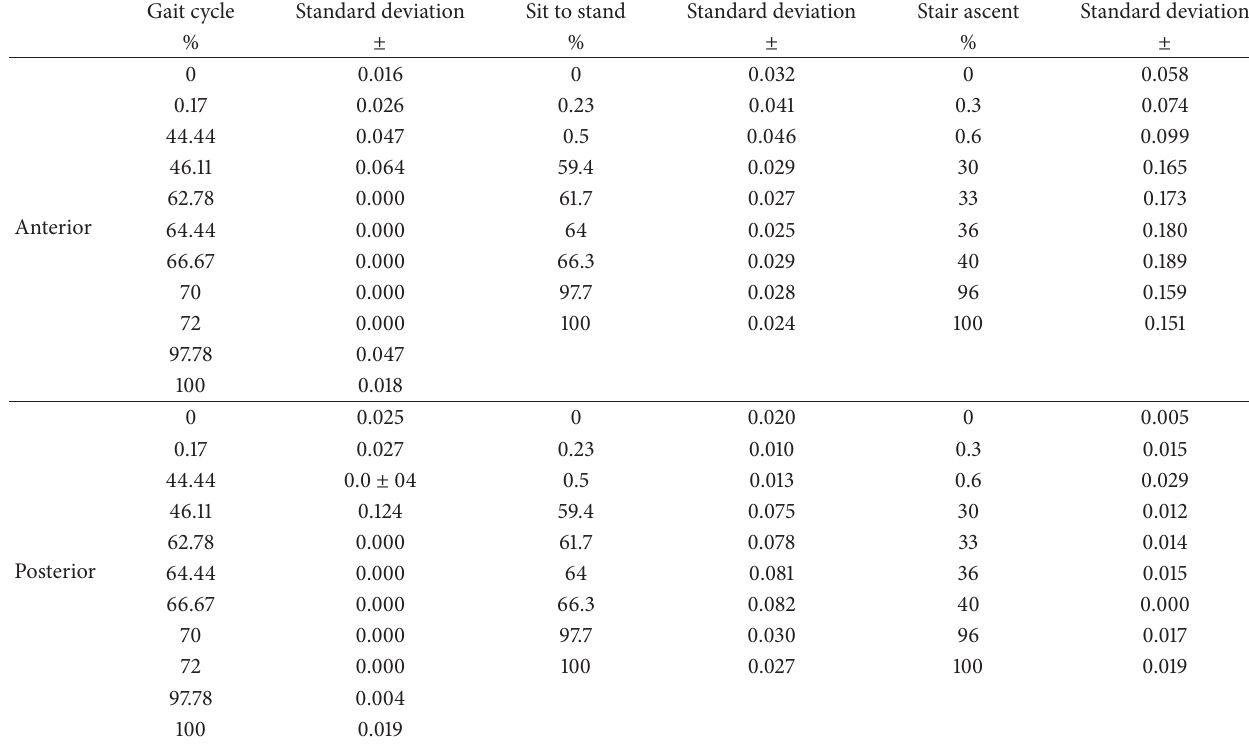
Table 2: Standard deviation values for